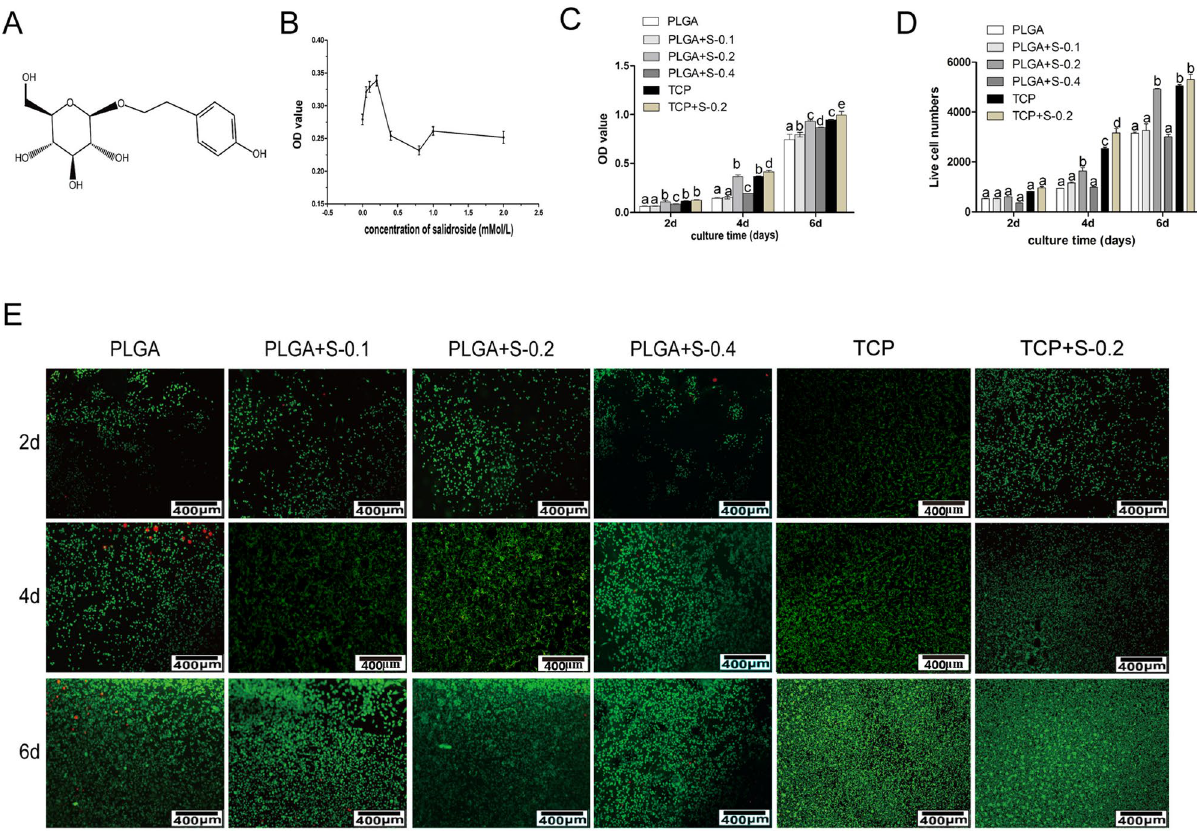
Figure 1. Effects of SDS on RSC 96 via MTT analysis in vitro . ( A ) Chemical structure of salidroside; ( B ) Preliminary drug screening analysis of RSC 96 treated on PLGA scaffold with different concentrations of salidroside after 3 days (n = 3, mean ± SEM); ( C ) Proliferative effects of salidroside on RSC96 on PLGA scaffold measured by MTT assay (n = 3, mean ± SEM). Different letters denote significances with P < 0.05 and the same letter shows no significant differences (P ≥ 0.05); ( D ) Quantitative data of the mean number of SCs. Data of each bar are shown as the mean of three independent experiments ± SD. Different letters denote significances with P < 0.05 and the same letter shows no significant differences (P ≥ 0.05); ( E ) Cell viability was measured by FDA/PI staining under microscope. (PLGA means cultured with 0 mM SDS, PLGA+S-0.1 means cultured with 0.1 mM SDS, PLGA+S-0.2 means cultured with 0.2 mM SDS, PLGA+S-0.4 means cultured with 0.4 mM SDS, TCP means cultured on TCP alone, TCP + s-0.2 means cultured with 0.2 mM SDS on